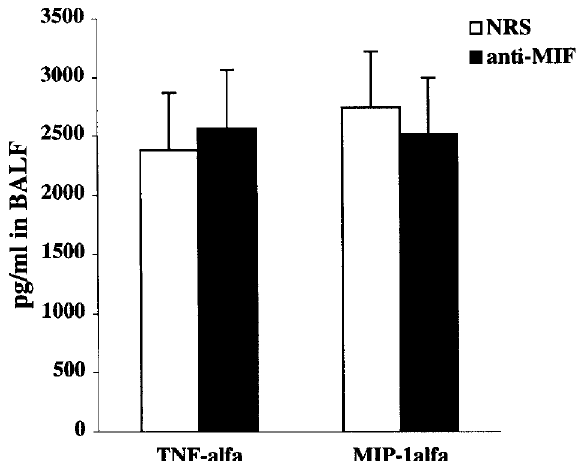
FIG. 5. Levels of TNF- a and MIP–1 a in BALF 4h after LPS instillation of mice treated with anti-MIF serum or NRS. Data are presented as mean ± SEM. NRS = NRS-treated animals ( n =8), anti-MIF = anti-MIF-treated animals ( n =8). Mice treated with anti-MIF serum exhibited similar levels of TNF- a and MIP–1 a in BALF as NRS-treated